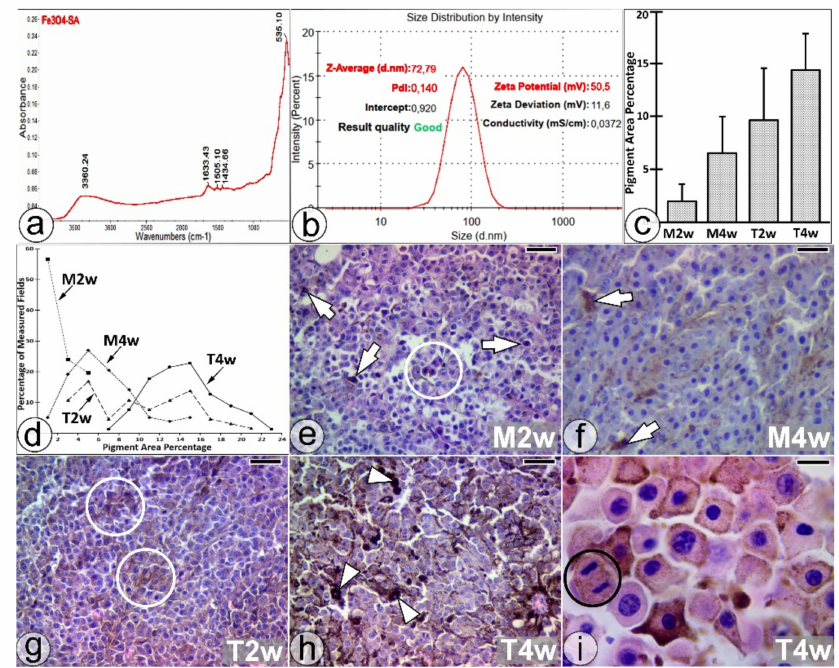
Figure 1. ( a ) FT-IR spectra and ( b ) the DLS size and zeta potential measurements of SaIONs. ( c ) PAP mean values ( ± SD) and ( d ) percentage ranges of the PAP distribution in the mea- sured fields. ( e – i ) Histological sections through untreated (M2w and M4w) and orally treated (T2w and T4w) melanoma tissue, with single PMCs (white arrows), PMC clusters (white circles), HPMCs (white arrow-heads), and PMC mitosis (black circle) highlighted. HE staining. Bar = 25 µ m ( e – h ); 10 µ m ( i